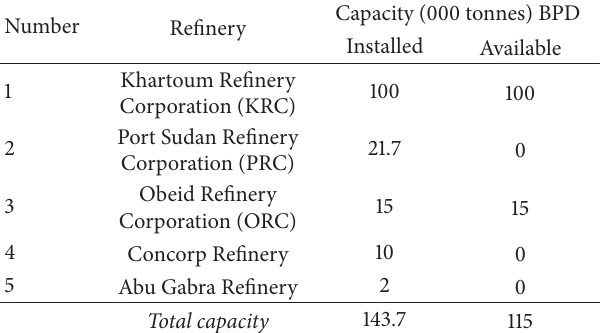
Table 10: Sudan refineries.